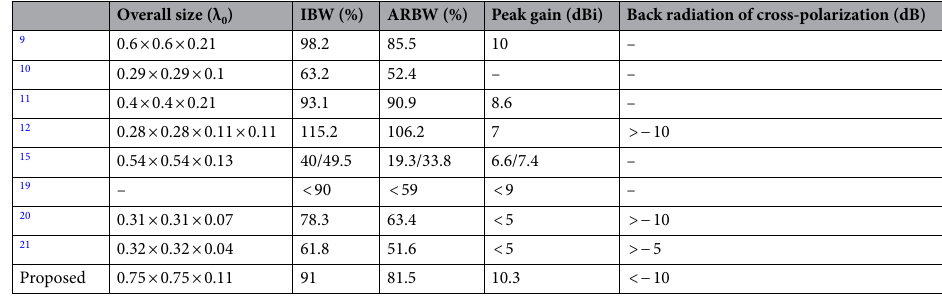
Table 1. Comparison between the proposed and the previously reported crossed-dipole antennas. λ 0 : Wavelength at the lowest frequency of passband. 19 : An antenna